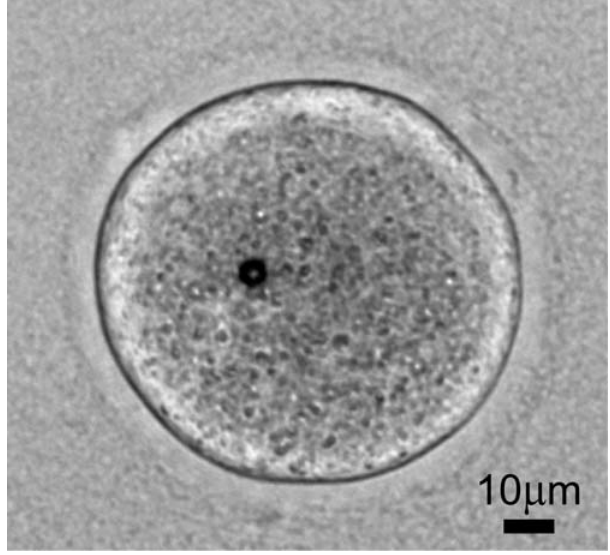
Figure 1. A magnetic bead inside of a mouse oocyte. A photomicrograph of a CD1 mouse oocyte having been injected